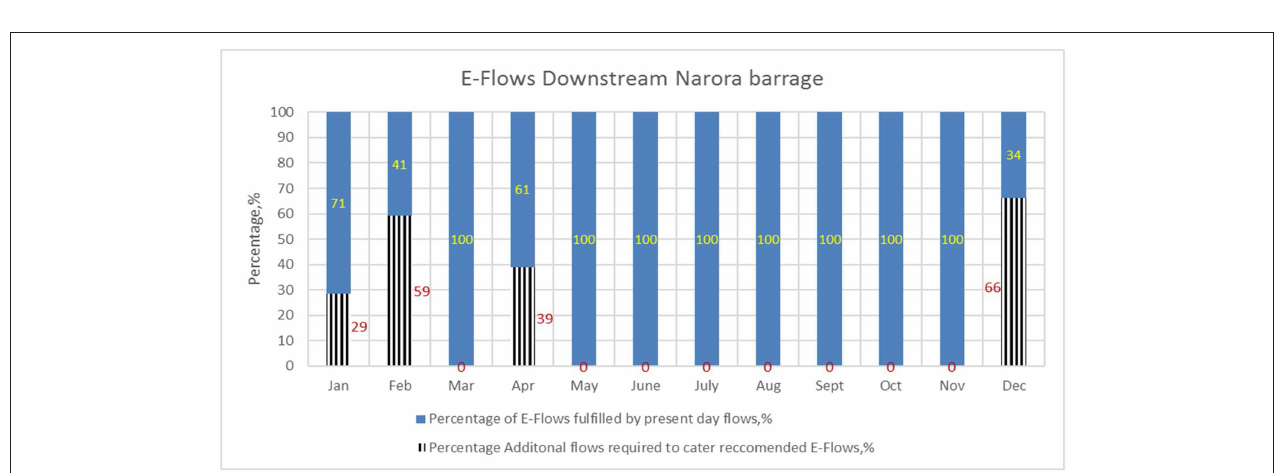
FIGURE 5 | Percentage of E-Flows and its shortfall in comparison to percentage in present day flows from Narora Barrage (headworks of Lower Ganga Canal) (Source: developed by WWF India, based on the information and data from IIT Kanpur).